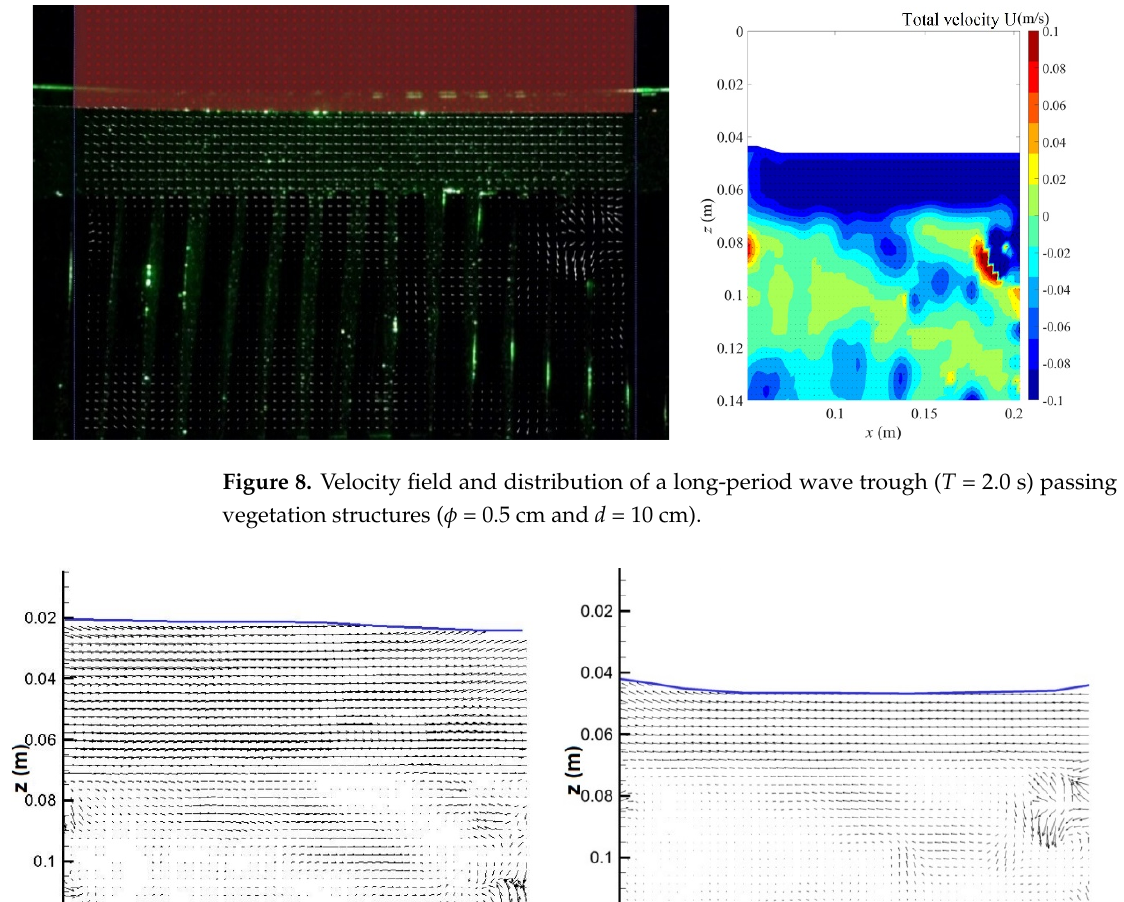
Figure 10. Velocity field and distribution of a short-period wave crest ( T = 0.5 s) passing through vegetation structures ( ϕ = 0.2 cm and d = 10 cm).